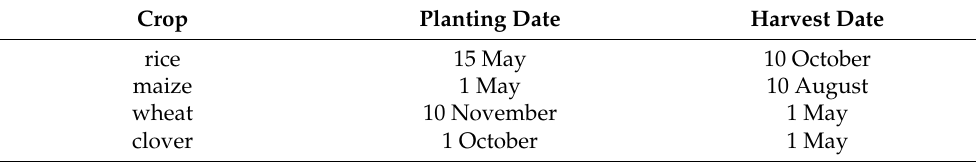
Table 1. Established crop calendar over the study site (Tanta, El Gharbia governorate, Egypt).